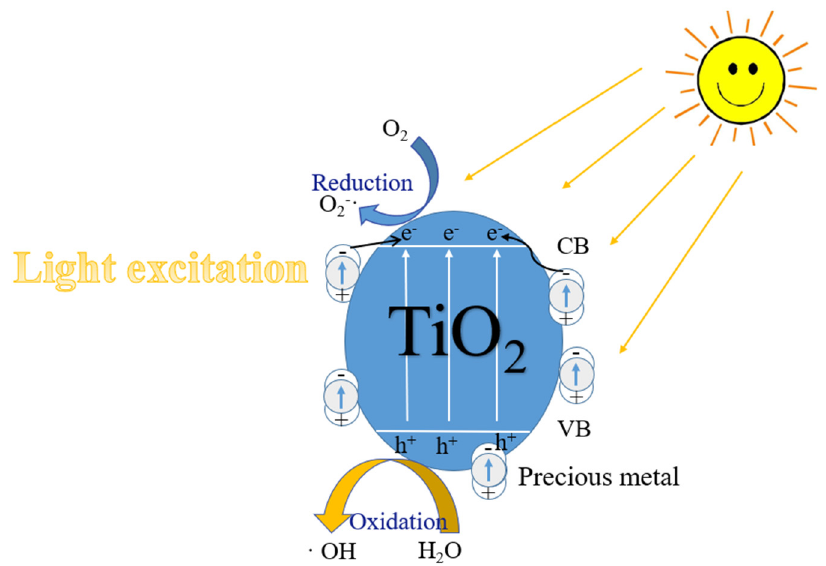
Figure 3. The mechanism of precious metal materials deposition.